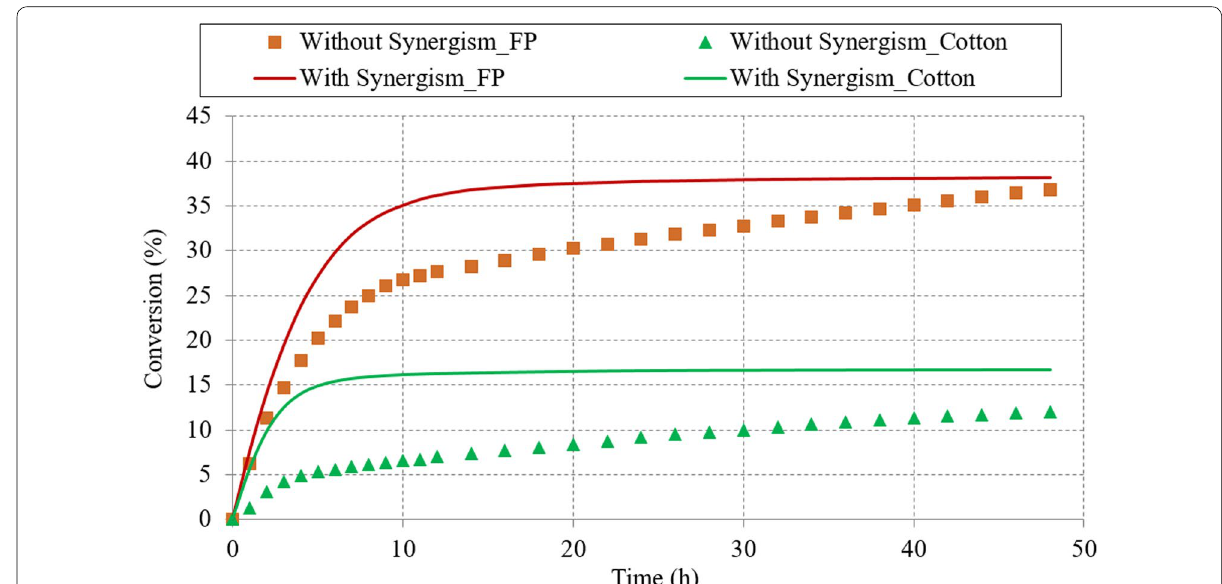
Fig. 16 Endo–exo synergism during hydrolysis of filter paper and cotton cellulose 25 g/L, EG I 10 mg/g glucans, CBHI 10 mg/g glucans (total 20 mg enzymes when acting in mixture 1:1). Solid lines are results from combined action of enzymes and lines with points (theoretical) are sum of conver- sions from action of individual